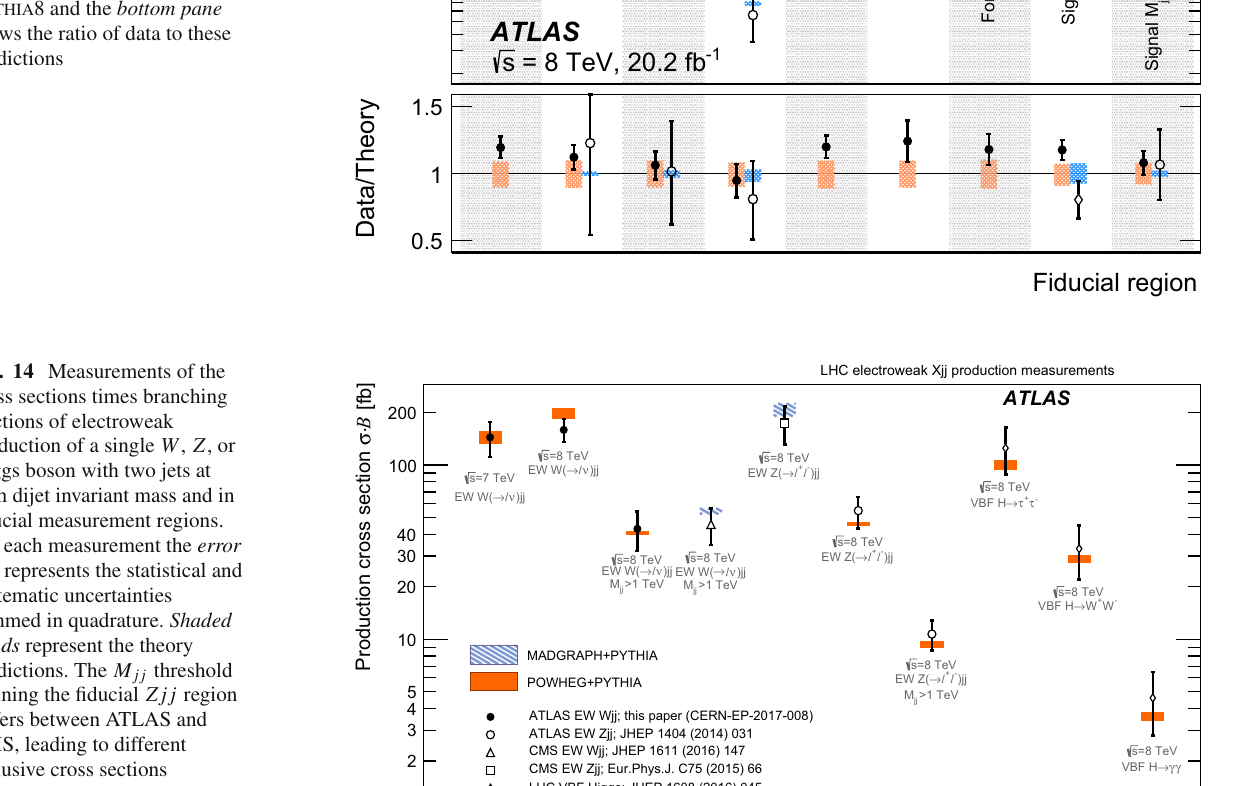
Fig. 13 Integrated production cross sections for QCD+EW W jj ( solid data points) and EW W jj ( open data points) production in each measured particle-level fiducial region in a single lepton channel; EW W jj production is only measured in fiducial regions where there is sufficient purity. For each measurement the error bar represents the statistical and systematic uncertainties summed in quadrature. Comparisons are made to predictions from Powheg + Pythia8 and the bottom pane shows the ratio of data to these predictions